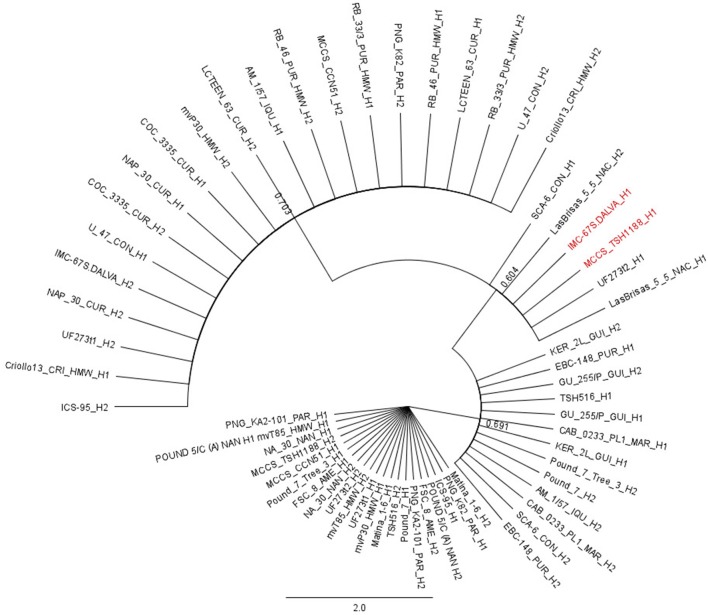
Neighbor Joining tree identifies the origin of the major QTL on chromosome VI (QTcNdp-chr6 and QTcXll-chr6). The red highlighted names are to show that the clones IMC-67.DALVA and TSH 1188 have the same haplotype H1, which was associated with CWC resistance in the MP01.